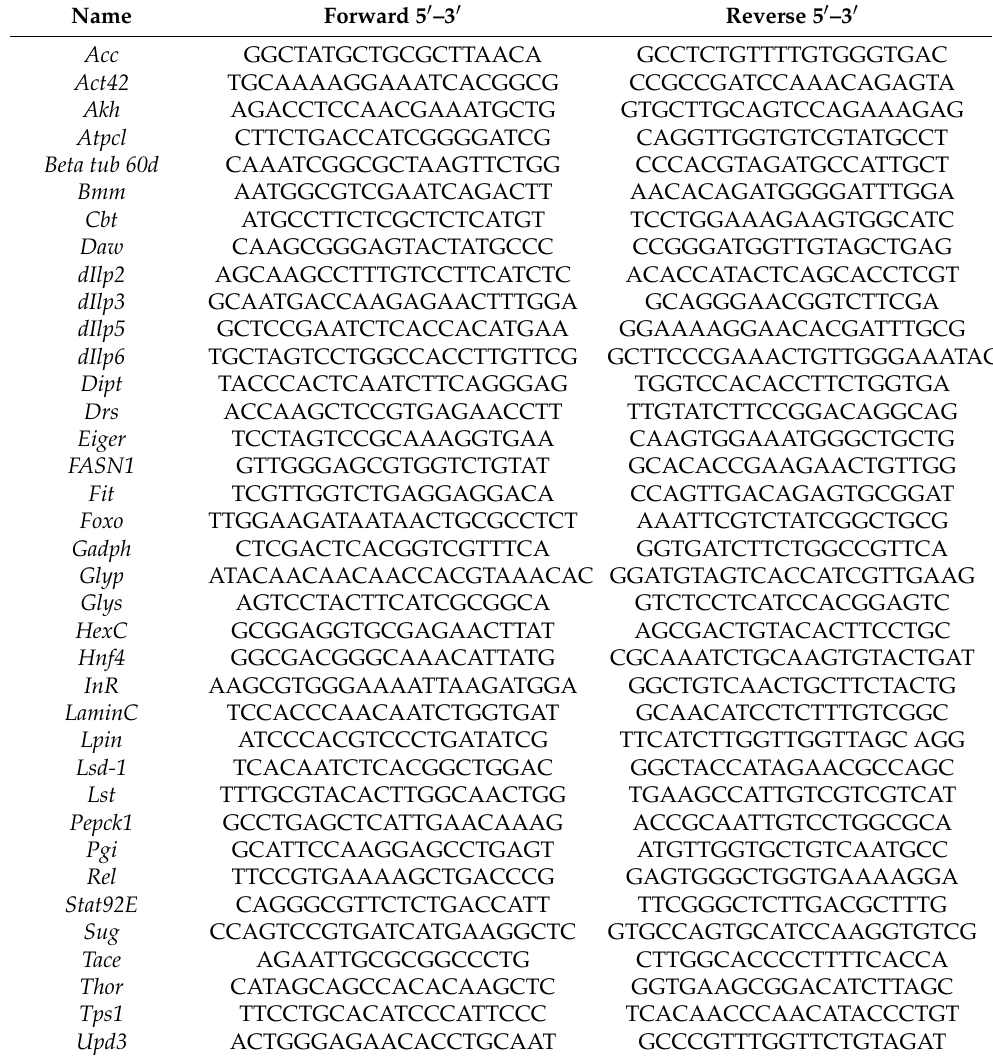
Table 2. Primer sequences for